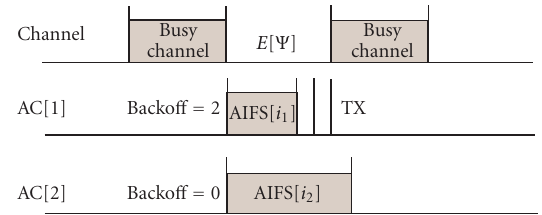
Figure 2: The AIFS di ff erentiation prevents a collision that other- wise would have